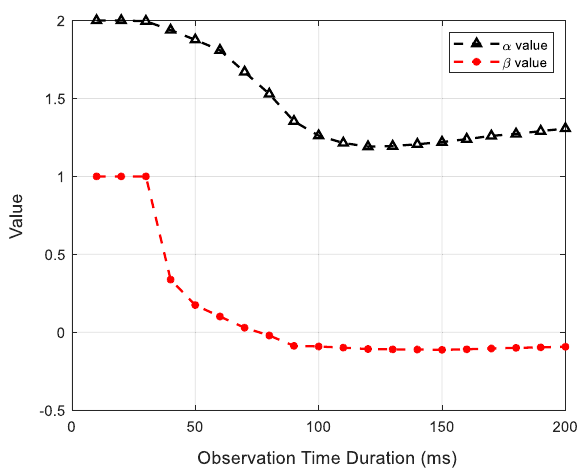
Fig. 8 α and β values with different observation time